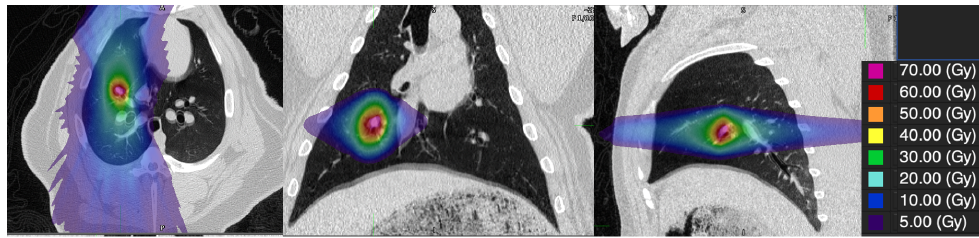
Figure 1. Example dose distribution delivered to the Swine